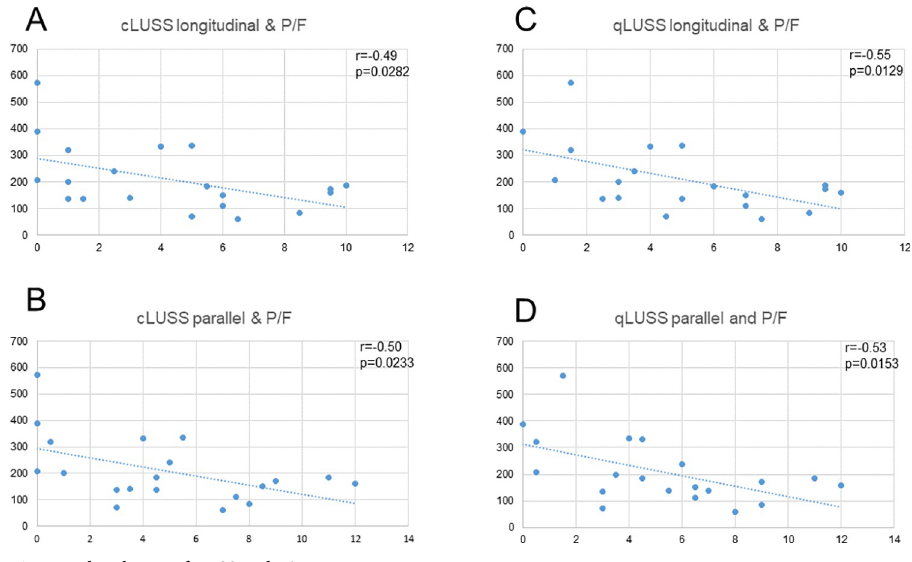
Fig 3. a-d. Relation of LUSS and P/F